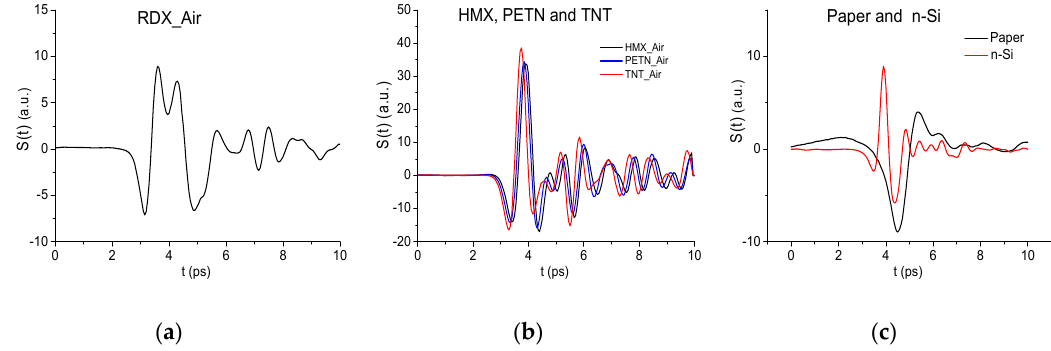
Figure 4. Standard THz signals RDX_Air ( a ) , HMX_Air, PETN_Air, TNT_Air ( b ) , and paper, n-Si ( c ).